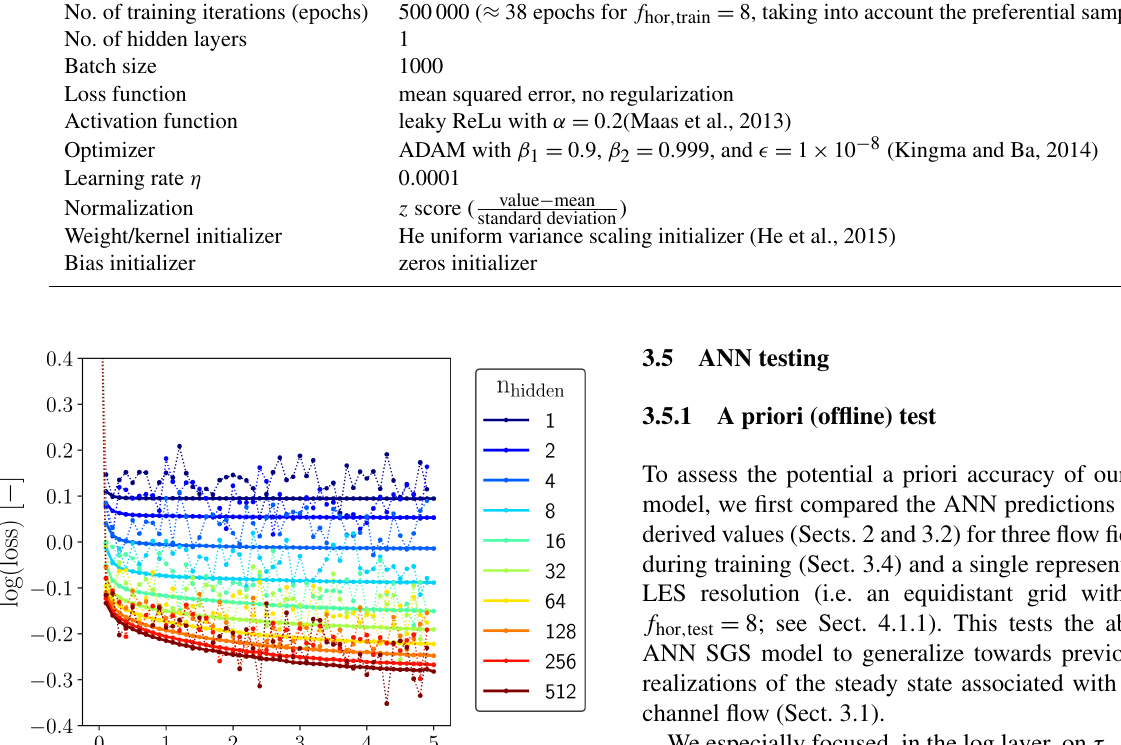
Table 2. Fixed hyperparameters and settings used in the ANNs we trained. No. of training iterations (epochs)